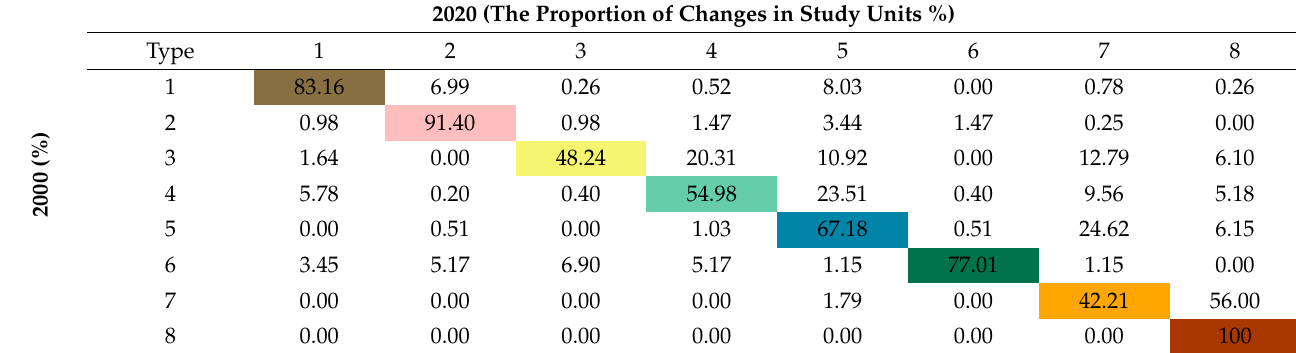
Figure 8. Sankey diagram for the comparison of LCTs in two-time intervals defined by three LCT maps for the years 2000, 2020 and 2040. Table 6. Transfer matrix of LCTs from 2000 to 2020.